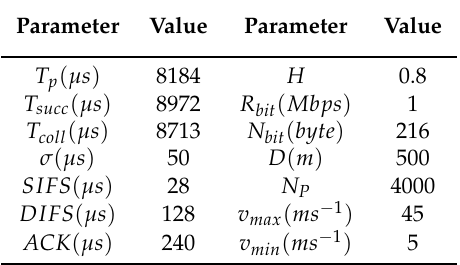
Table 3. System parameters.